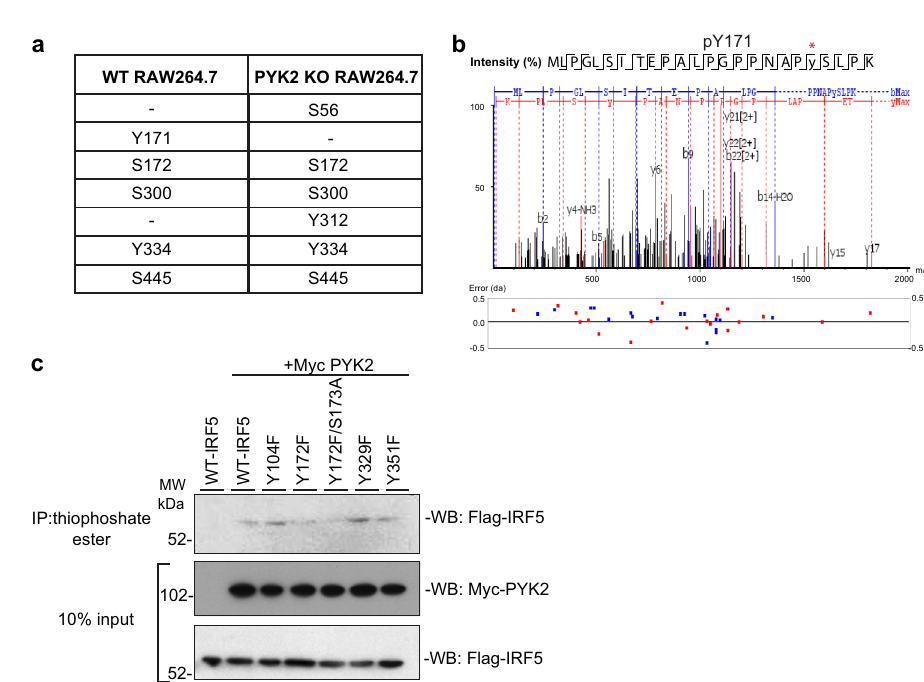
Fig. 3 PYK2 phosphorylates IRF5. a Phosphorylation sites identi fi ed in LPS-stimulated WT and PYK2 KO RAW264.7 cells. b MS/MS spectrum of the IRF5 derived tryptic peptide 152-179 indicating phosphorylation at positions Y171. Fragmentation ions of the b- and y- series are indicated in blue and red, respectively. c In vitro kinase assay and immunoblot of IRF5-site-speci fi c tyrosine mutants. HEKTLR4 cells were co-transfected with FLAG-IRF5 tyrosine mutants as indicated and Myc-PYK2. 10% lysate was kept for input and the remaining was used for in vitro kinase reactions. Kinase assays were detected by western blot using antibodies against Flag-(IRF5) and Myc-(PYK2). Representative blots from three independent experiments are shown. Source data are provided as a Source Data fi